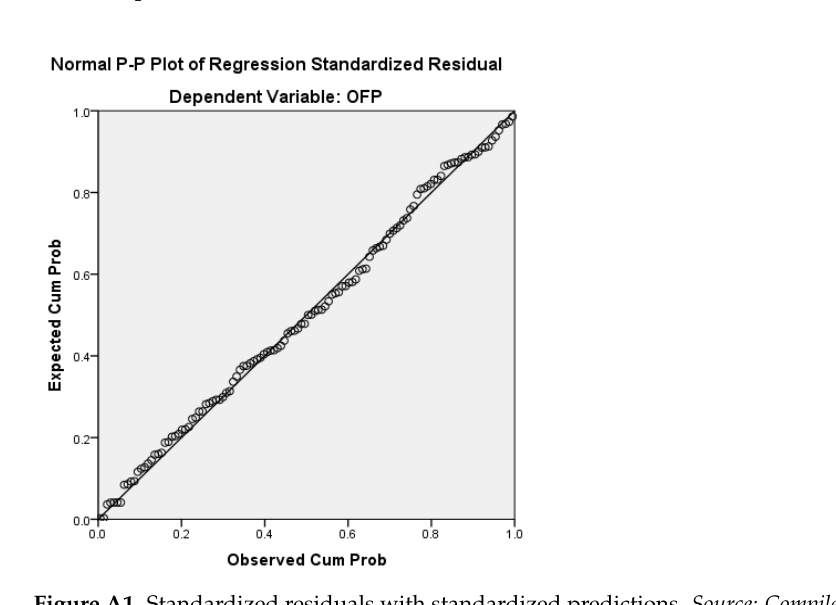
Figure A1. Standardized residuals with standardized predictions. Source: Compiled by the Authors.